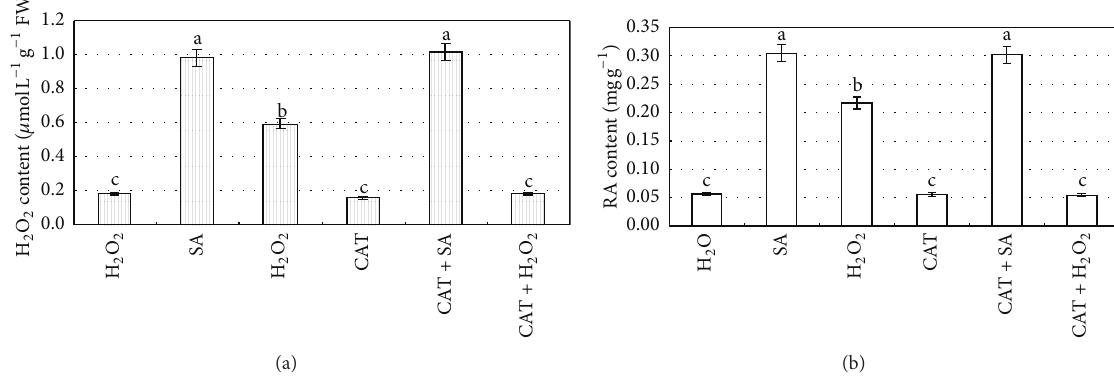
Figure 4: Influences of CAT (a scavenger of H 2 O 2 ) on the generation of H 2 O 2 (a) and the biosynthesis of RA (b) in the suspension cultured cells treated by SA and/or exogenous H 2 O 2 . 6-day-old suspension cultured cells treated with CAT (100U) 30 min before SA treatment were harvested at 8 h (for H 2 O 2 analysis) and 2 d (for RA analysis) later, and the H 2 O 2 and rosmarinic acid contents were then determined. The SA concentration is 22.5 mg/L. The exogenous H 2 O 2 concentration is 10mM. Values are means of three independent experiments. Bars represented standard errors. Different lowercase letters represent the significant differences between the concentrations of H 2 O 2 (a) and RA (b) after each treatment at the level of 5%.